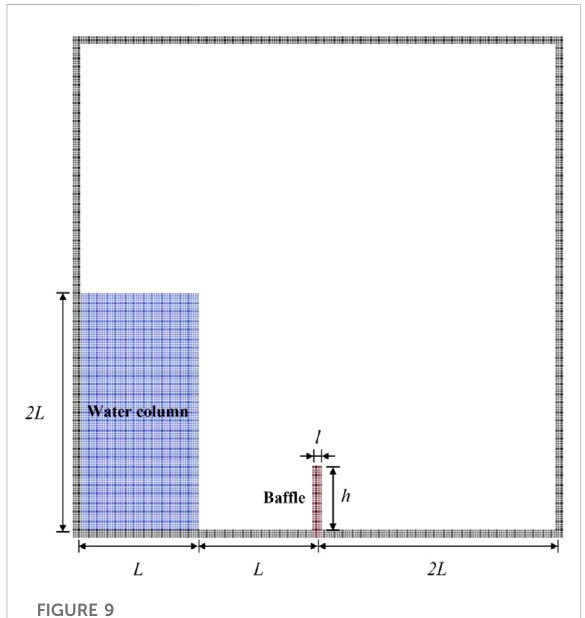
The initial con fi guration of the model: breaking dam on a baf fl